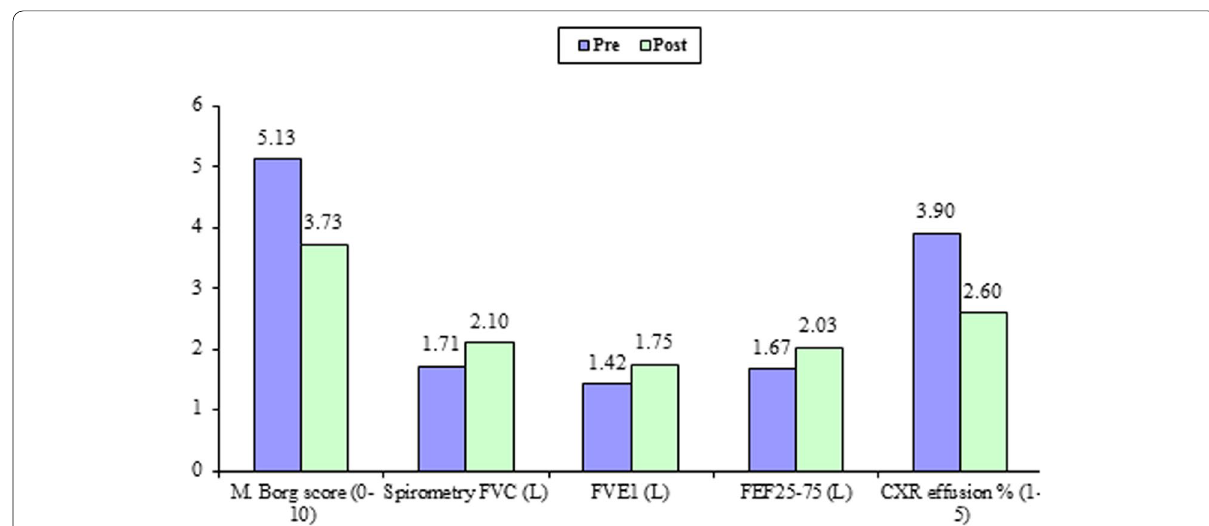
Fig. 1 Improvement in functional and radiologic parameters after therapeutic